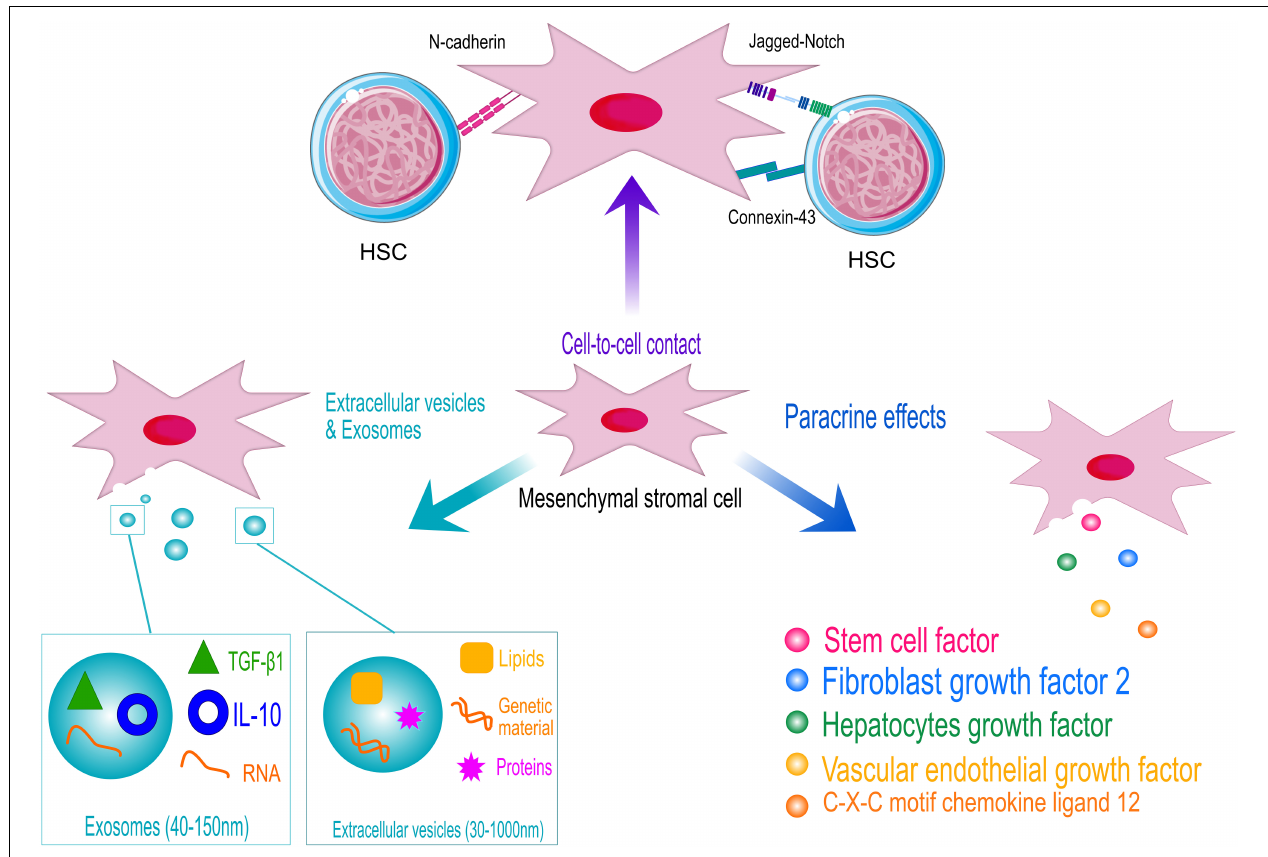
FIGURE 2 | Schematic representation of the hematopoietic supportive activities of human mesenchymal stromal cells (MSCs). MSCs support hematopoietic stem and progenitor cell (HSPC) homeostasis by cell-contact, through the interaction of specific ligands expressed on MSCs surface with HSPC receptors (N-cadherin and Notch). Adherent junction, such as connexin43, also play a role in the control of HSPC metabolism to protect cells from excessive activation. However, MSCs exert their hematopoietic function mainly through the secretion of supportive factors and the release of extracellular vesicles and exosomes. HSC models are licensed by